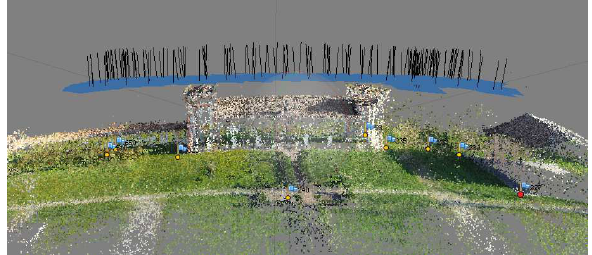
Figure 6: bowl-effect still visible in alignment with GCPs.